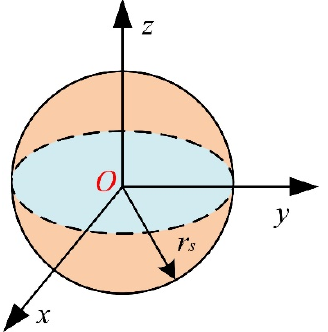
Figure 2. 3D sensor node perception model.